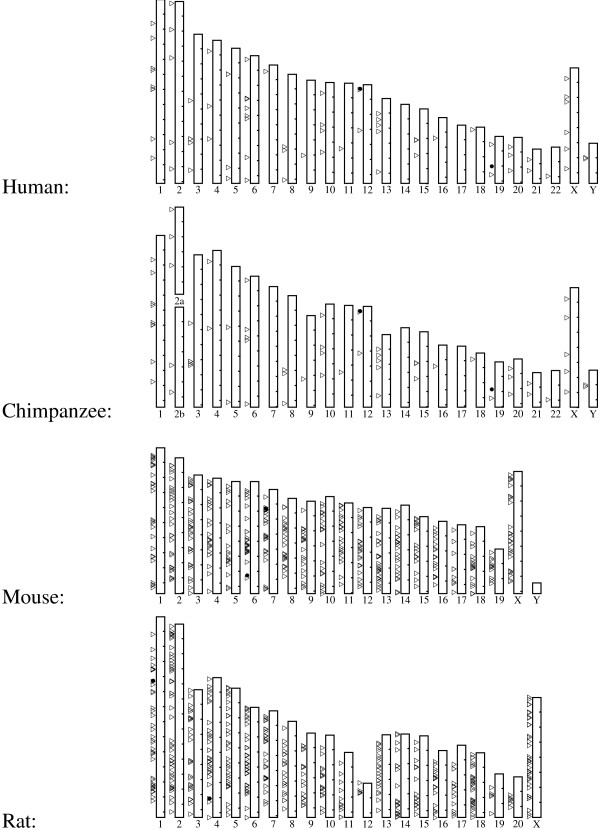
Pseudogene locations. Chromosomal distribution of GAPDH pseudogenes in the human genome. Pseudogenes are marked by triangles. The parent genes are marked by solid circles, occuring on human chromosomes 12 and 19 (spermatogenic), chimpanzee chromosomes 12 and 19 (spermatogenic), mouse chromosomes 6 and 7 (spermatogenic), and rat chromosome 1 (spermatogenic) and 4. The tick marks along the right edge of a chromosome mark 20 million base pair intervals, starting from the top.